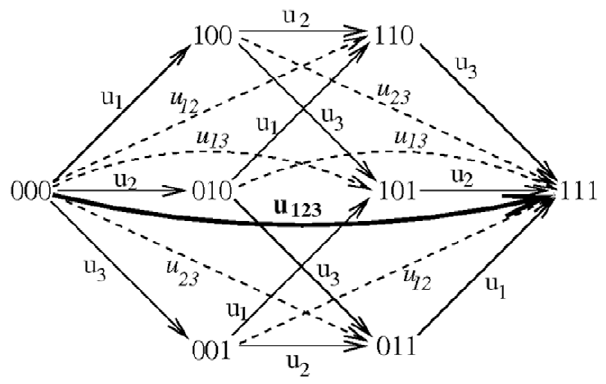
Figure 1. A mutation network for a three-drug treatment. The nodes correspond to different resistance phenotypes, and the arrows to mutation processes; mutation rates are marked next to the arrows. Singly-resistant mutations are denoted my solid lines, doubly-resistant mutations – by dashed lines and italic font, and the triply-resistant mutation by a thick line and bold font.